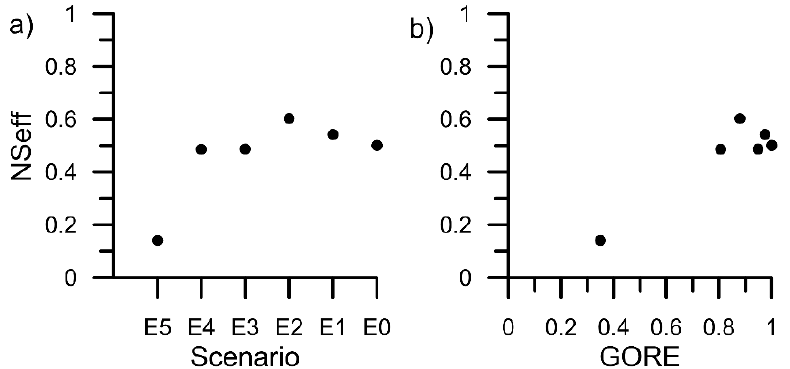
Figure 7. Impact of rainfall quality on model performance (NSeff) of a calibrated model with low rainfall quality against ( a ) rainfall monitoring scenario and ( b ) GORE index.